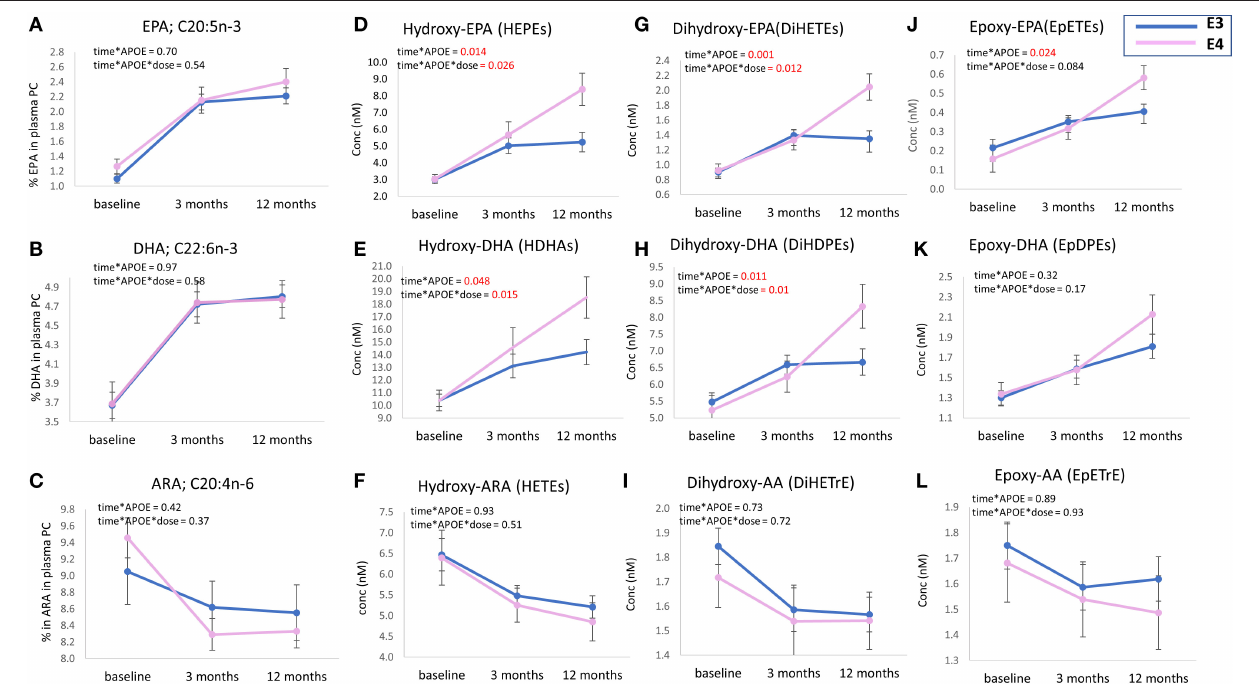
FIGURE 2 | Plasma levels of parent PUFAs (EPA, DHA, and ARA) (A–C) and sum of EPA, DHA, and ARA-derived oxylipins; (D–L) , at baseline, 3m and 12m. Levels of EPA, DHA, and ARA (% of total fatty acids) and concentrations of plasma oxylipins (nM) are presented as mean ± SEM. Data were analyzed by repeated measures ANOVA. A model was built to identify the independent (main) effect of APOE and dose, and “ APOE *dose” interaction effect. Age, sex, BMI, and baseline parent PUFA for oxylipins were used as covariates in the model. Within subject factor: time. The absolute concentrations of all HEPEs, HDHAs, DiHETEs, DiHDPEs, EpETEs, and EpDPEs covered by the analytical method were summed from the individual data, i.e., 9 × HEPEs, 10 × HDHAs, 4 × DiHETEs, 5 × DiHDPEs, 3 × EpETEs, and 4 × EpDPEs. APOE3 n = 66, APOE4 n =